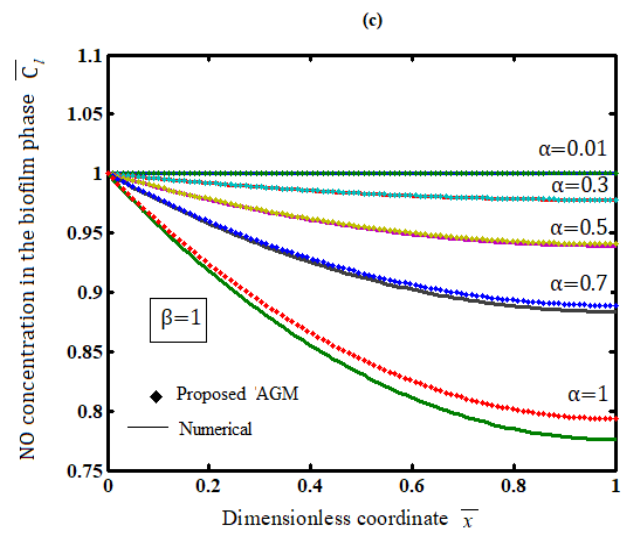
Figure 4. Dimensionless NO concentration in the biofilm phase C l computed using Equation (15) for various experimental values of α and β (Table A2) when ( a ) β = 0.01 ( b ) β = 0.5 ( c ) β = 1.